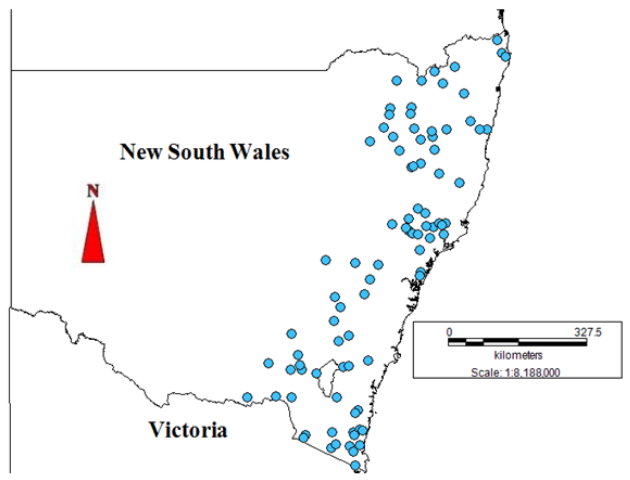
Figure 1. Spatial location of the selected 88 catchments in New South Wales (NSW), Australia. Table 1. Summary of descriptive statistics of selected catchment and climatic